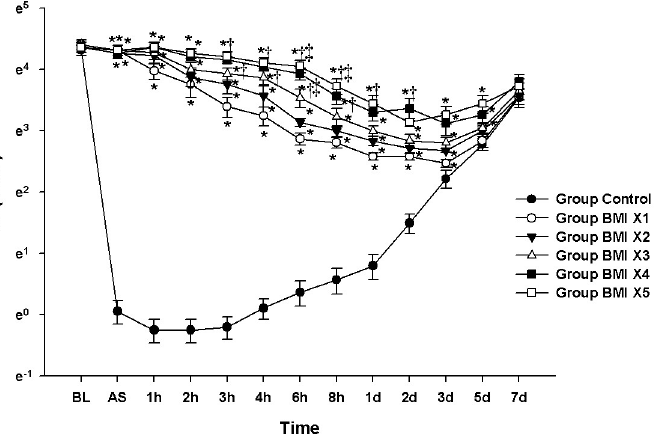
Fig 1. Evaluation of analgesic effect according to dose of BMI1008: BMI1008 dose response test. The graphs are presented as means ± standard error of the mean of the log-transformed mechanical withdrawal threshold with von Frey filaments. BL: baseline, AS: after surgery. � P < 0.05 compared with Group Control, † P < 0.05 compared with Group BMI X 1, ‡ P < 0.05 compared with Group BMI